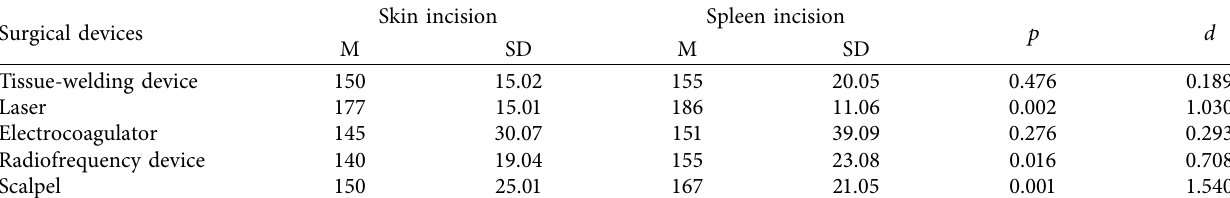
Table 2: Difference in rabbit heart rate between skin and spleen incision (beats per minute).